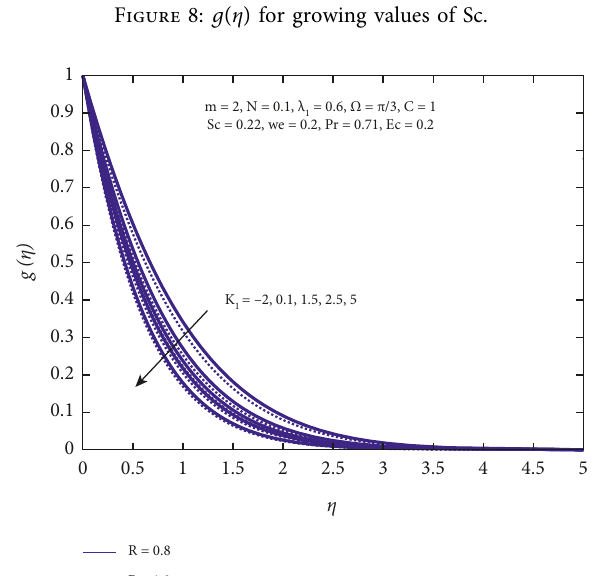
Figure 9: g ( η ) for growing values of K